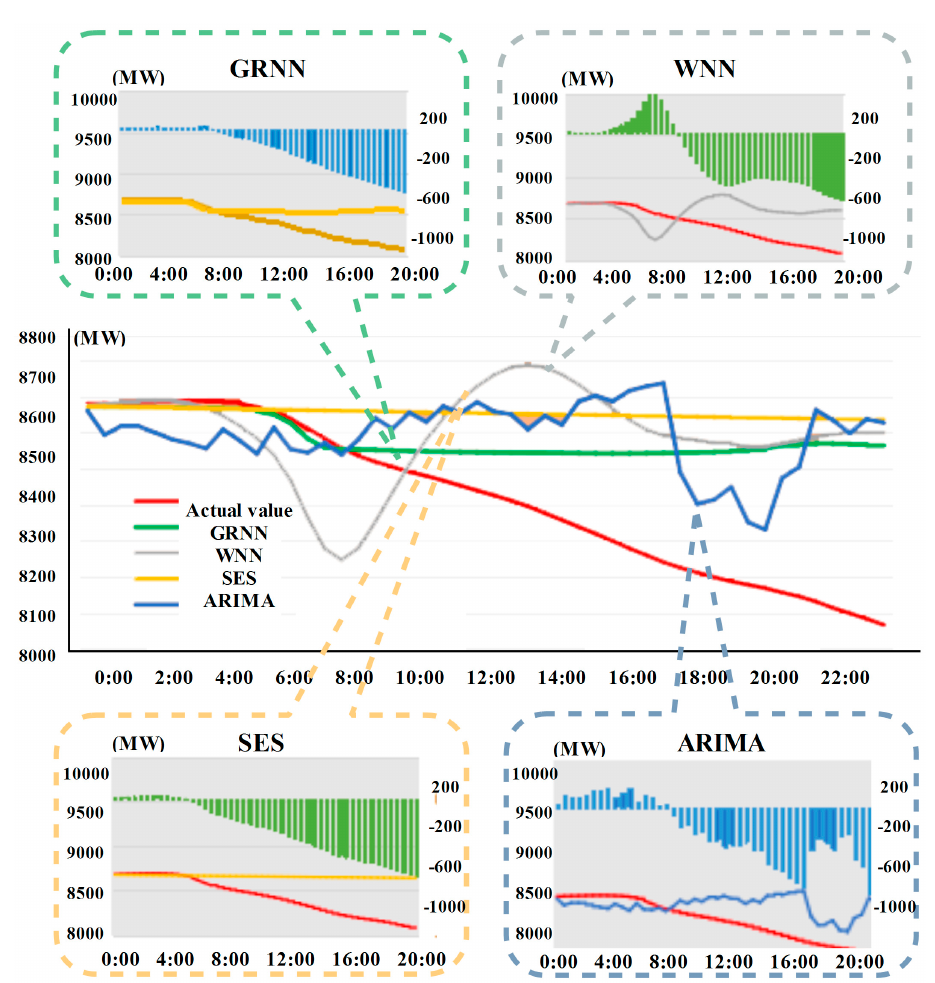
Figure 4. The generalized regression neural network model.